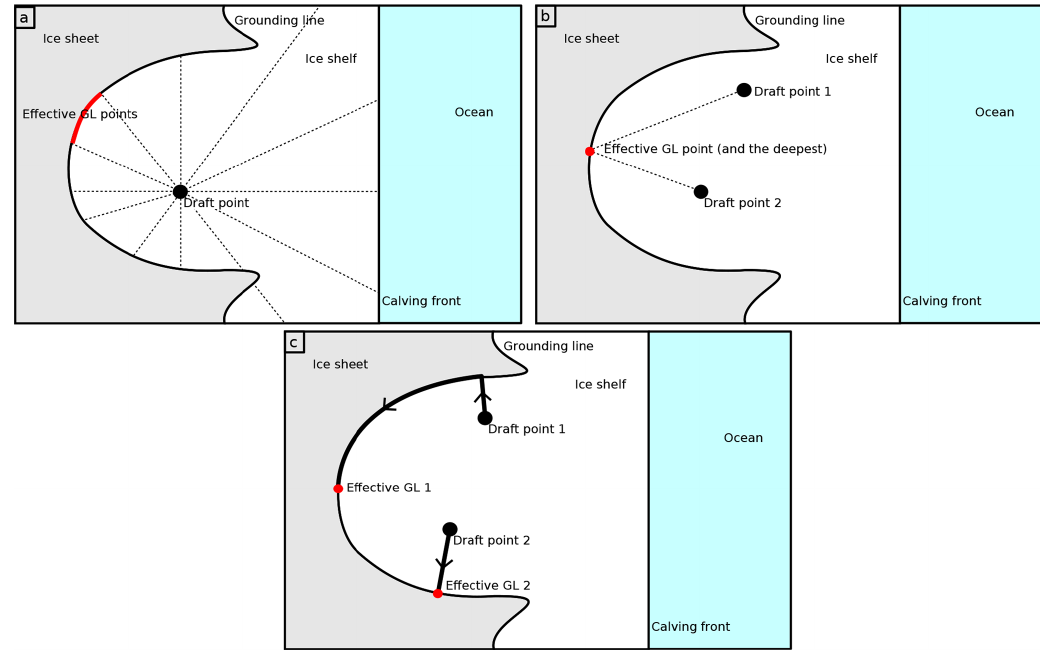
Figure D1. Computing the effective grounding-line depth and angle for the four plume parameterisation implementations. Panel (a) illustrates both the published implementation PME 1 (Lazeroms et al., 2018) and the one appearing in the corresponding discussion article PME 2 (Lazeroms et al., 2018), here with 12 directions (vs. 64 triangles used in the present paper). PME 1 and PME 2 differ by the calculation of the effective slope, which is not depicted here. Panel (b) illustrates the simple implementation PME 3 and panel (c) illustrates the asymmetric implementation PME 4